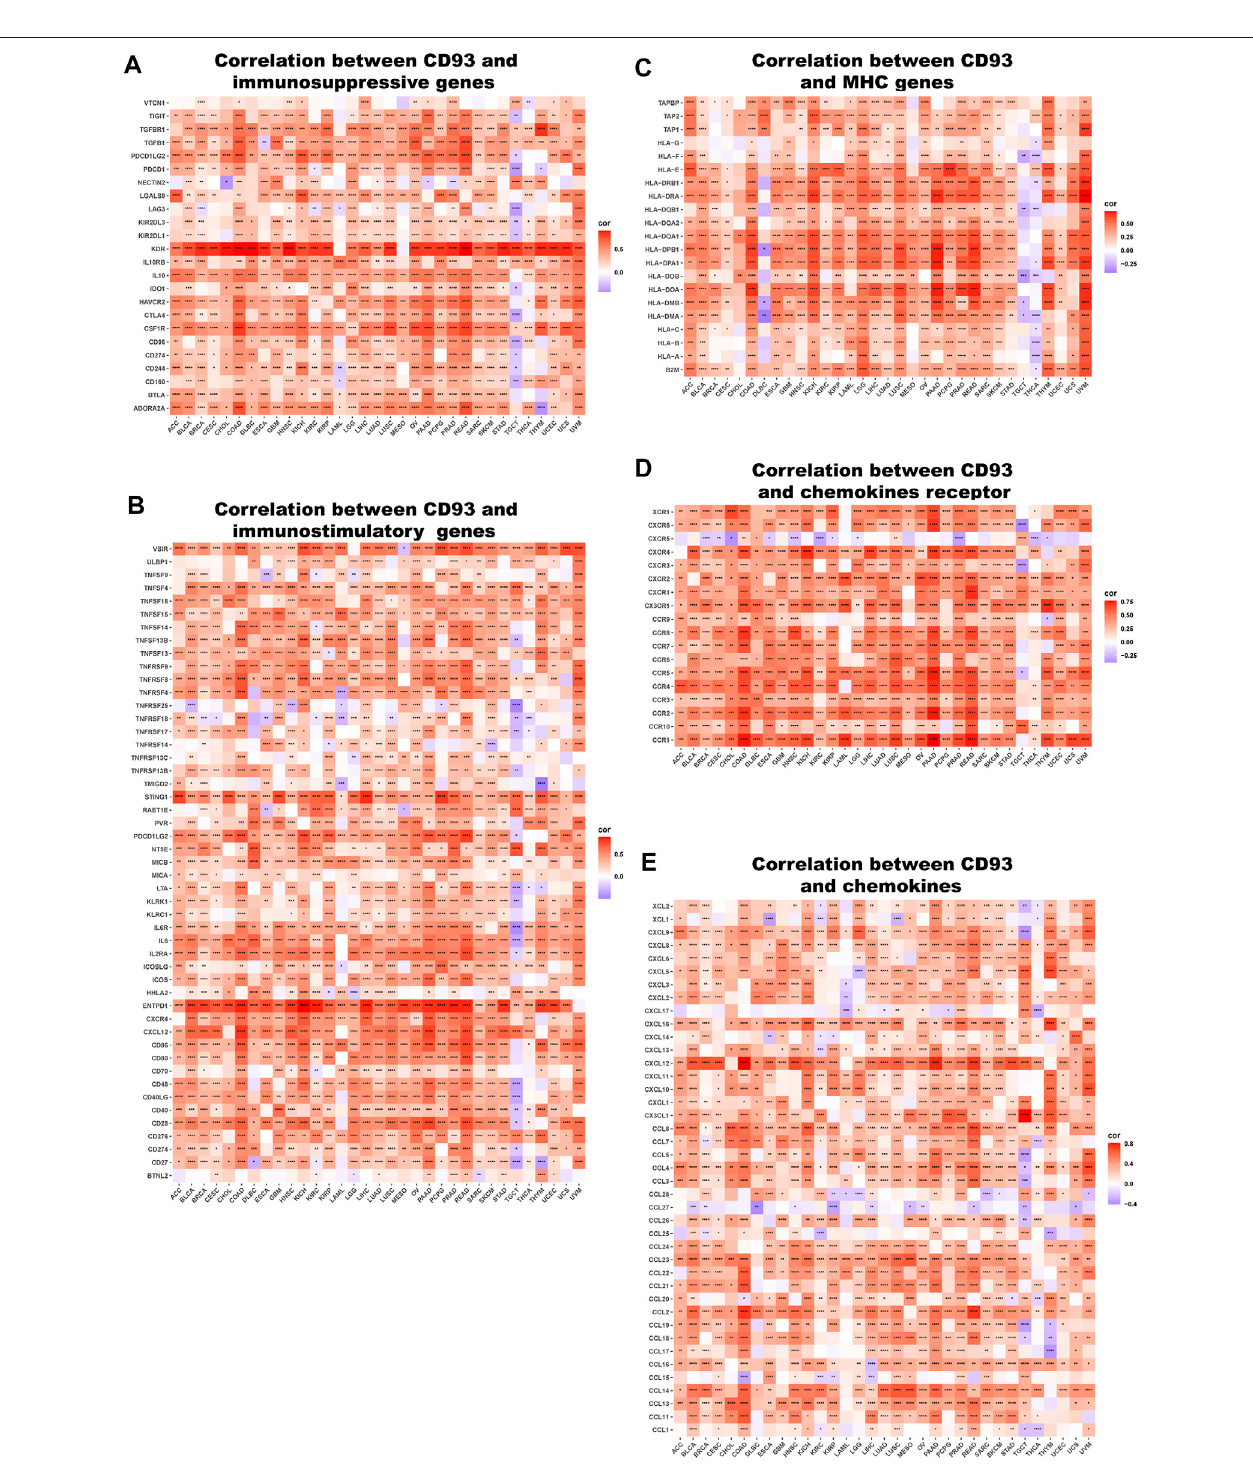
FIGURE 8 | Relationship between CD93 and (A) immunosuppressive factors, (B) immunostimulatory factors, (C) MHC genes, (D) chemokine receptors, (E) and chemokines. * p < 0.05, ** p < 0.01, *** p < 0.001, **** p < 0.0001.